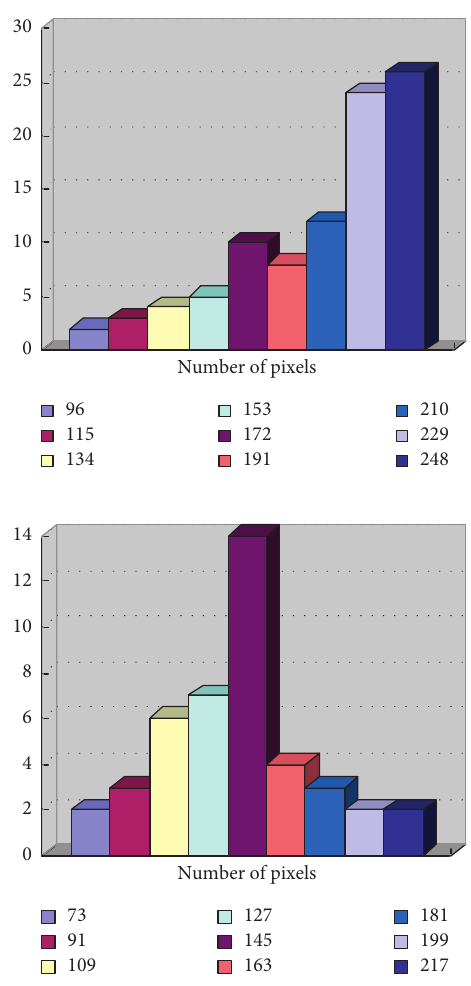
Figure 3: Red histogram with red light on and